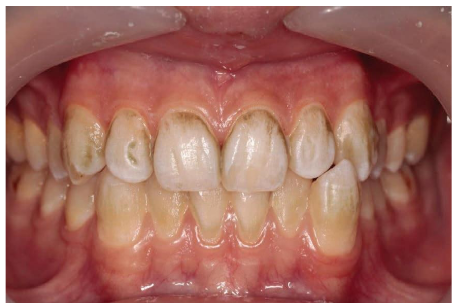
Figure 2: Teeth after prophylaxis with pumice powder using a low- speed handpiece at the end of the frst